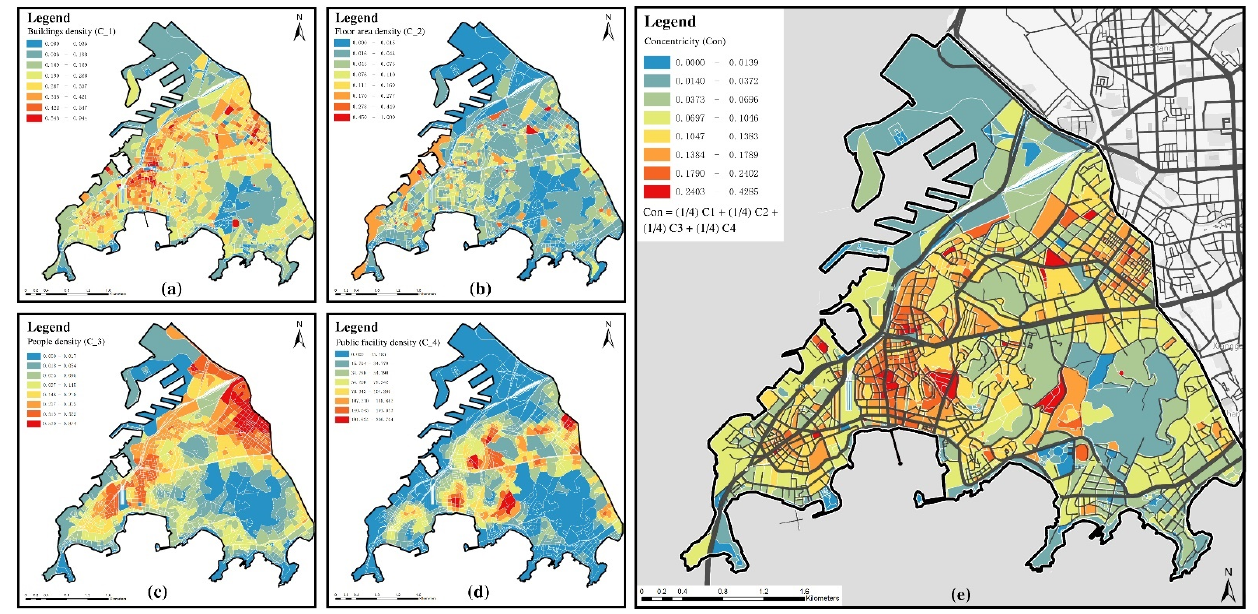
Figure 7. Connectivity analysis. (a) Buildings density. (b) Floor area density. (c) People density. (d) Public facility density. (e) Concentration composite index.